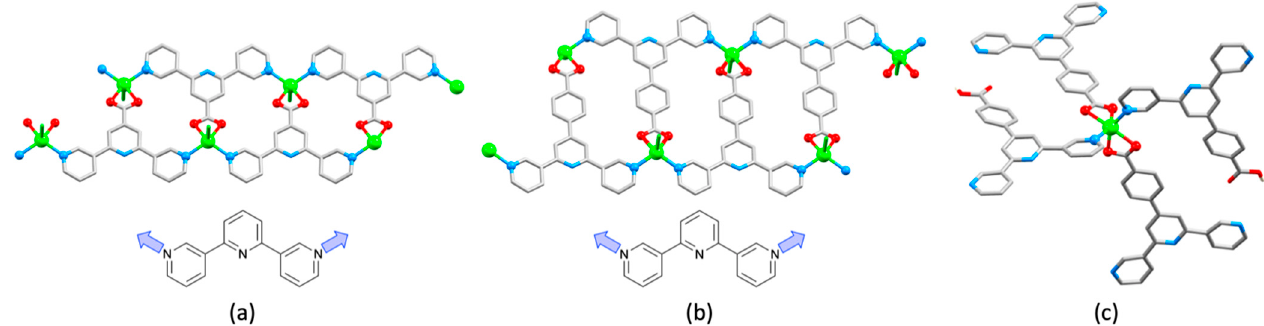
Figure 40. Part of the 1D-polymer in ( a ) Zn 2 Cl 2 ( 60 ) 2 ] n (CSD refcode XEWGUD), and ( b ) [ZnCl( 61 )] n (CSD refcode FIJJIP); the conformation of the 3,2 (cid:48) :6 (cid:48) ,3”-tpy unit is shown in planar notation for both structures. ( c ) The structure of the mononuclear complex [Zn( 61 ) 2 (H 61 ) 2 ] in the dihydrate (refcode FEJJEL); H atoms except for those in the CO 2 H groups are omitted.